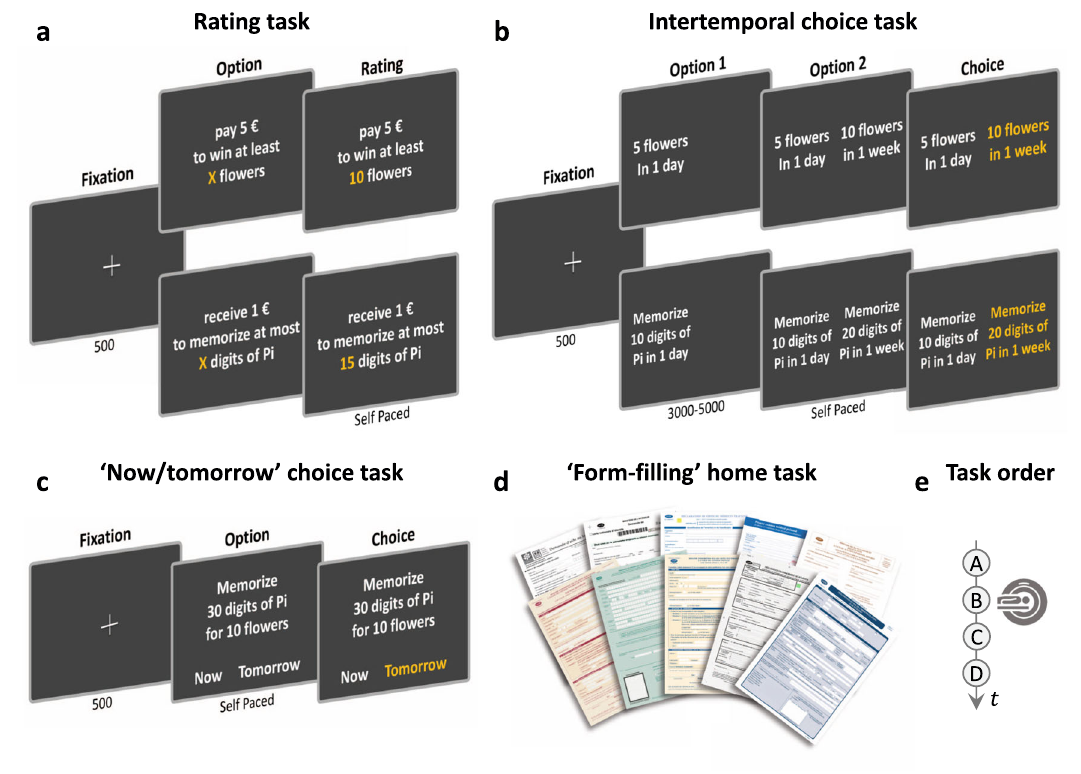
combining reward and effortitems.Then they indicatedwhethertheypreferred to exert the effort “ Now ” , and obtain the reward immediately, or “ Tomorrow ” ,